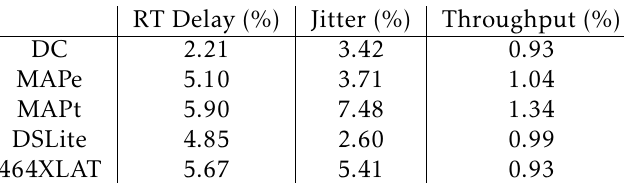
Figure 3. Jitter results Table 4. Relative standard deviation